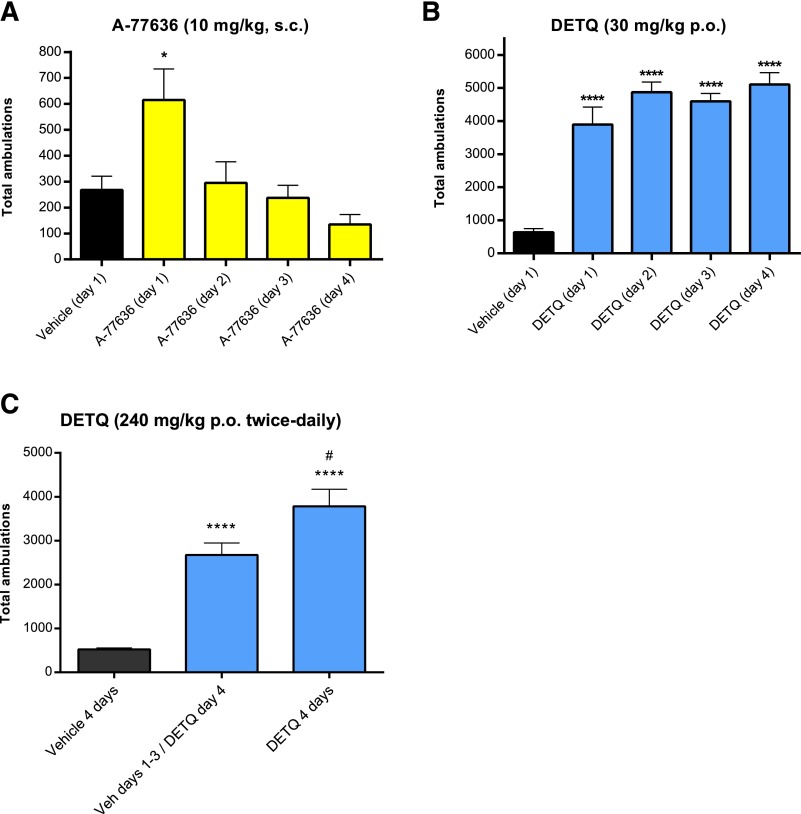
LMA responses to A-77636 and DETQ on repeated dosing. (A, B) Once-daily oral dosing. The LMA response to A-77636 was measured from 60 to 90 minutes because of its slower onset. (C) LMA response to DETQ after twice-daily oral dosing with a high dose of DETQ. The hD1 mice were given 240 mg/kg DETQ (or vehicle) twice daily for 2 days, dosed with 240 mg/kg (or vehicle) on the morning of day 3, then dosed with 240 mg/kg on the morning of day 4, at which time the LMA was measured. The values shown are mean ± S.E., n = 7–8. Results for drug-treated animals were compared with vehicle using Dunnett’s multiple comparisons test: (A and B) *P < 0.05, ****P < 0.0001; or a two-sided t test: (C) ****P < 0.0001 versus vehicle; #P < 0.05 versus animals treated with vehicle on days 1–3 and DETQ on day 4.